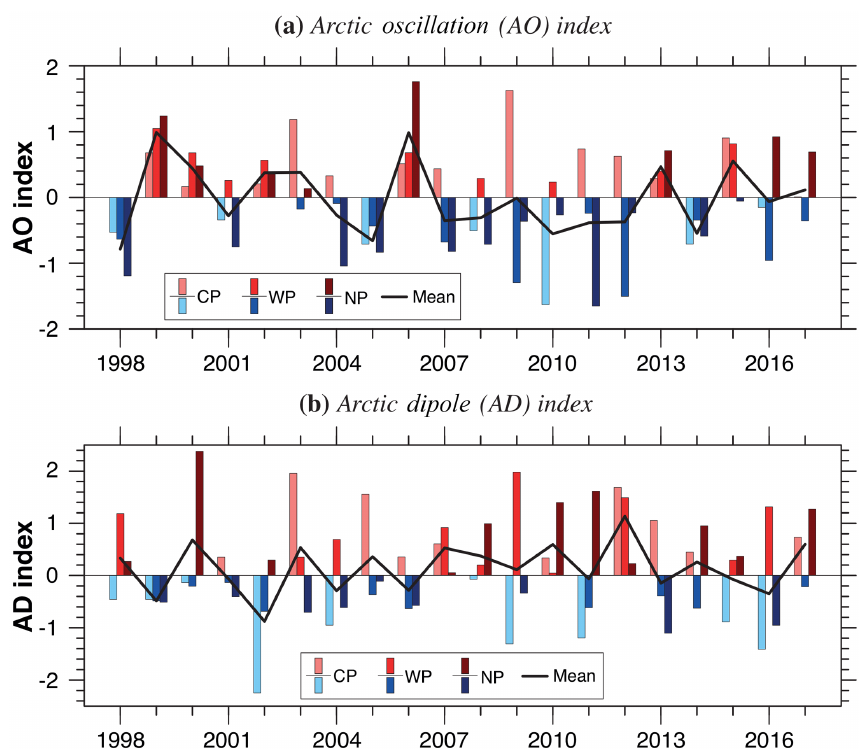
Figure 12. Time series of (a) Arctic oscillation (AO) and (b) Arctic dipole (AD) indices for the Northern Hemisphere over the ACLOUD/PASCAL comparison period (1998–2017) based on ERA-I data. Lines and bars indicate campaign and key period averages, respectively. These are defined as 23 May–26 June (mean), 23–29 May (the cold period; CP), 30 May–12 June (the warm period; WP), and 13–26 June (the normal period; NP),